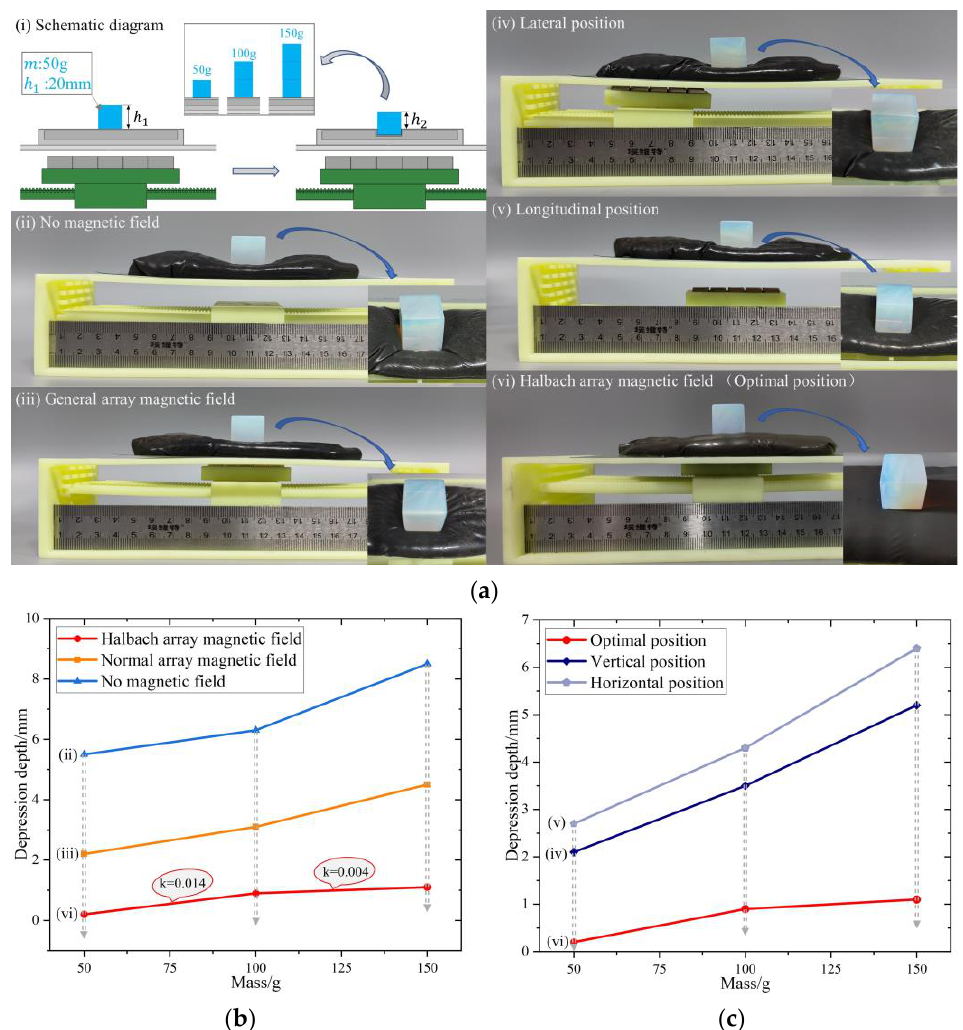
Figure 12. ( a ) Variable stiffness experiment. ( b ) The depth of depression of the MRG layer under different magnetic field conditions (k is the slope). ( c ) The depth of depression of the MRG layer at different locations. ( i ) Schematic diagram, ( ii ) No magnetic field, ( iii ) General array magnetic field, ( iv ) Lateral position, ( v ) Longitudinal position, ( vi ) Halbach array magnetic field (Optimal position).